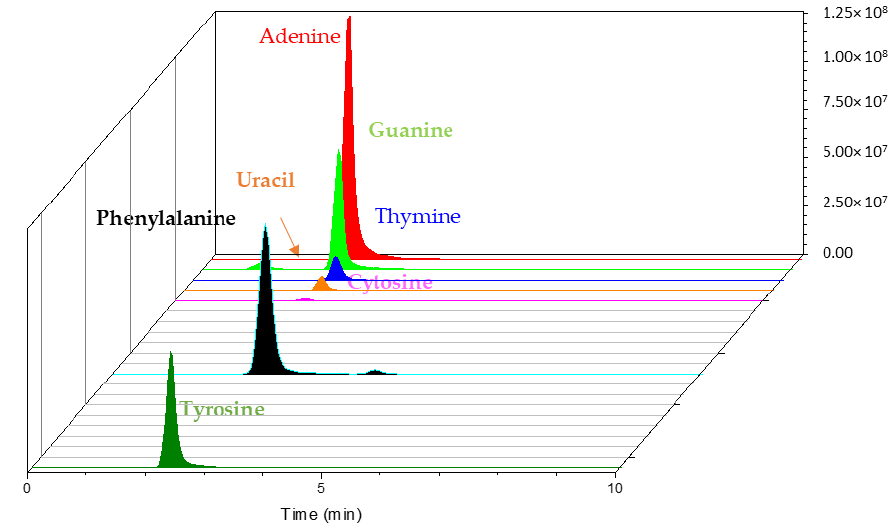
Figure 6. Extracted ion chromatogram of trapped amino acids and nucleobases on Hypersil Gold aQ (50 mm × 1 mm, 40 °C) from a 1 mL water sample. Backflush-elution with 20% ACN.